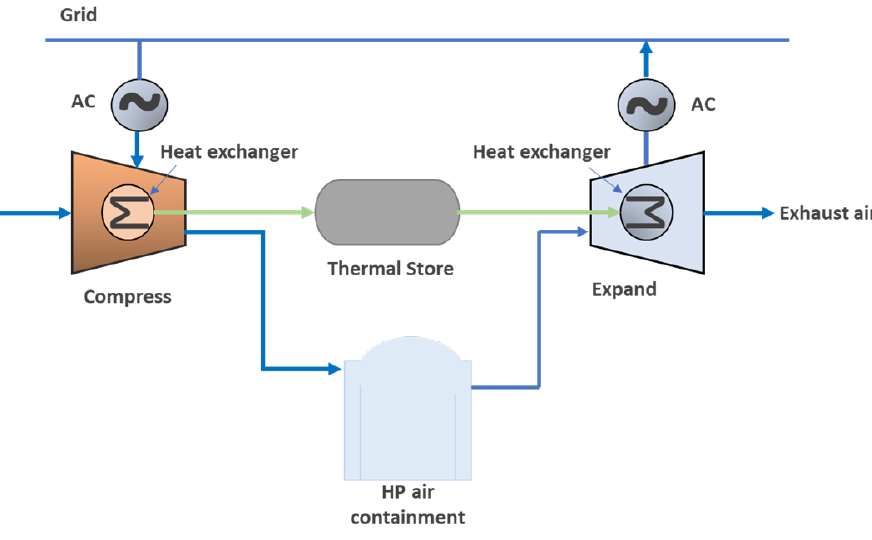
Figure 7. Schematic diagram of I-CAES.